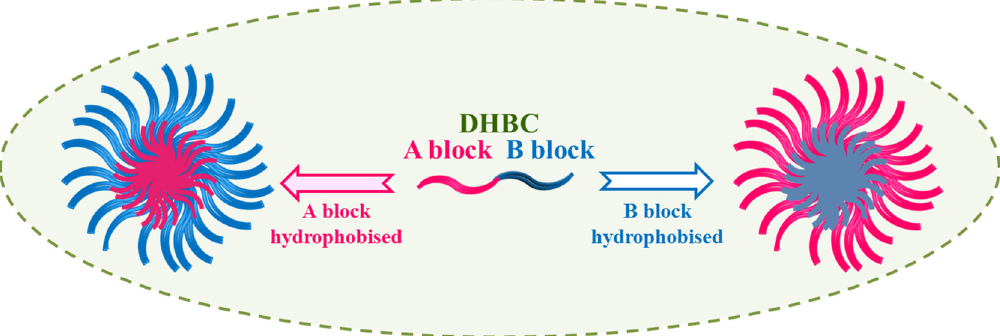
Figure 10. Illustration of S chizophrenic micelles